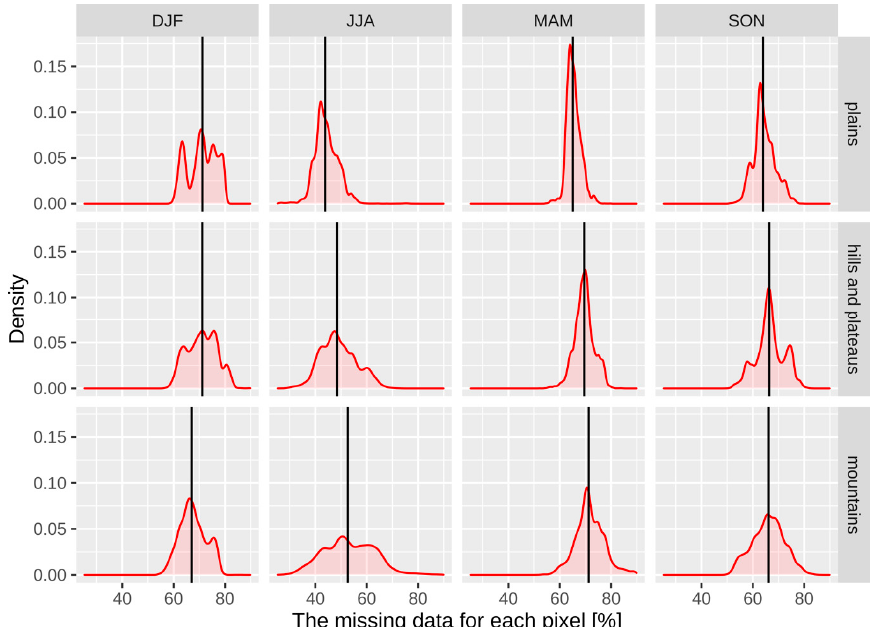
Figure 3. Seasonal density plots of the percentage of the missing LST data computed for each pixel by altitudinal steps. The vertical black lines represent the average percentages of the missing values for each subset of the data.